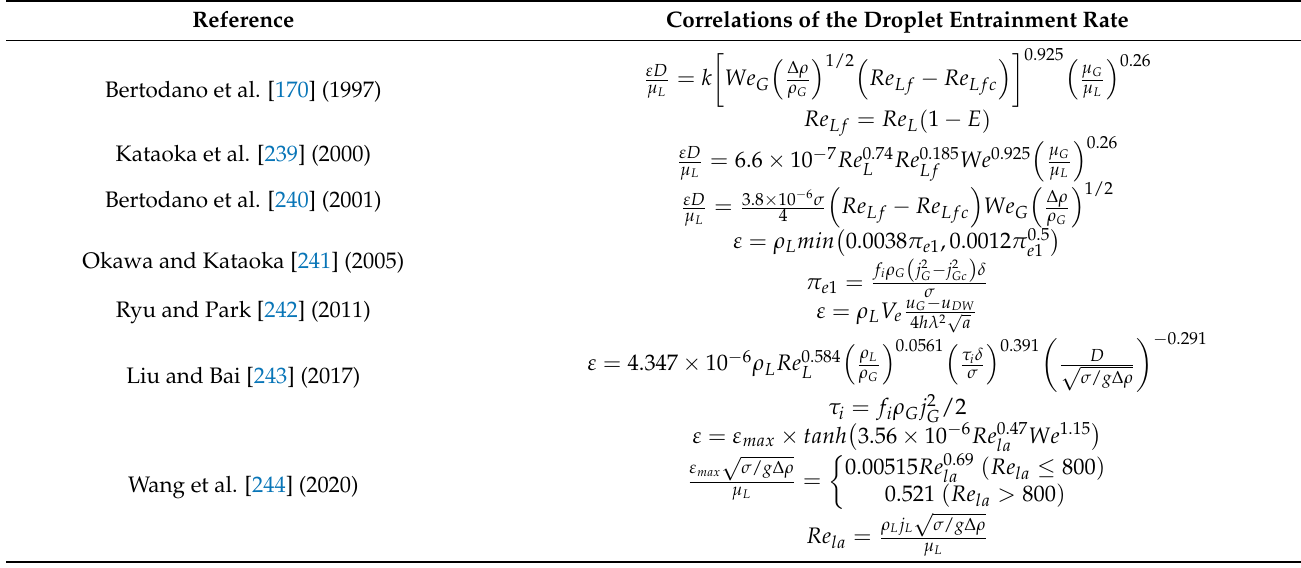
Table 4. Correlations for the droplet entrainment rate in annular flows.